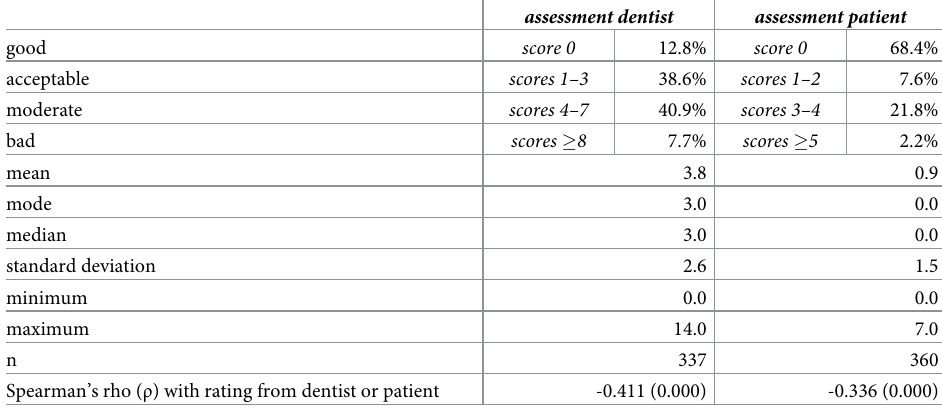
Table 3. Level of oral health of older people who visit the dental practice, according to assessment dentist and assessment